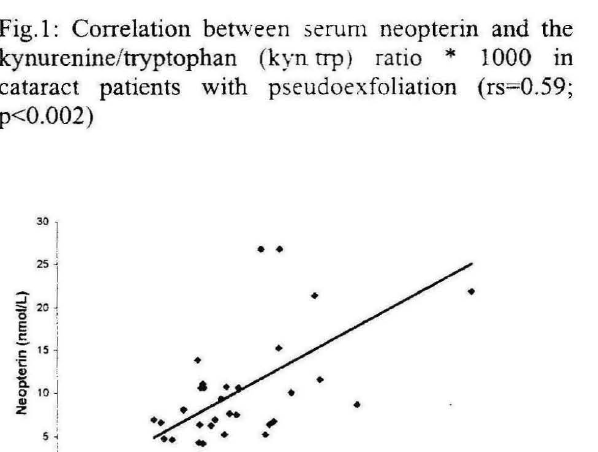
Fig.2: Correlation of serum kynurenine (squares) and neopterin (rhombs) concentrations with serum selenium content (neopterin: rs=0.45, not significant; kynurenine: rs =0.78,